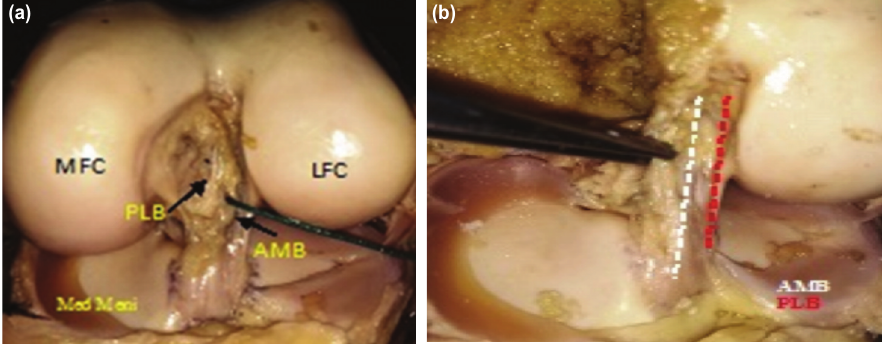
(a) AM bundle ACL demonstration. (b) PL bundle demonstration. Fig. 2: